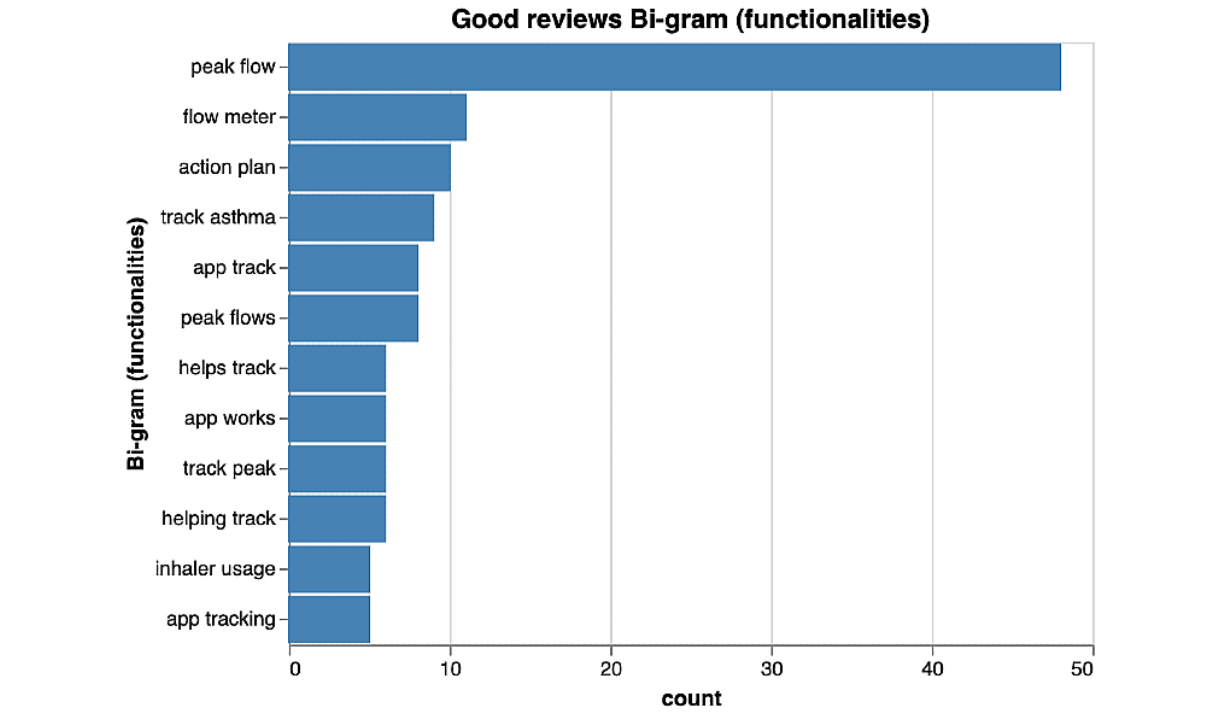
Figure 2. Bi-gram results of functionalities of highly rated asthma mobile